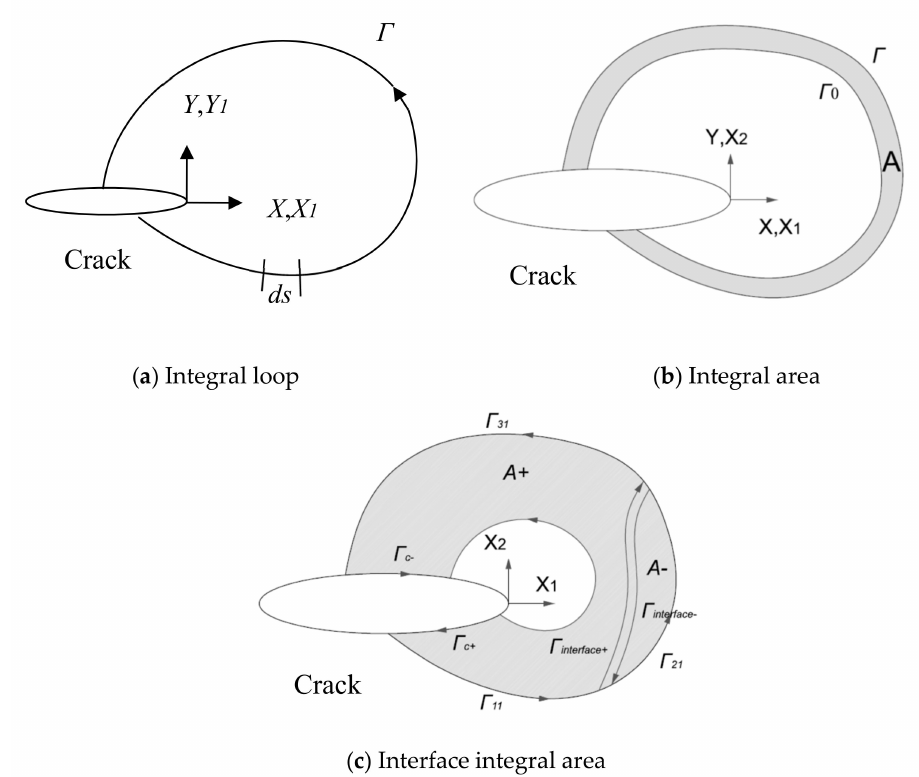
Figure 6. Counterclockwise integral loop around the crack tip. ( a ) Integral loop; ( b ) Integral area; ( c ) Interface integral